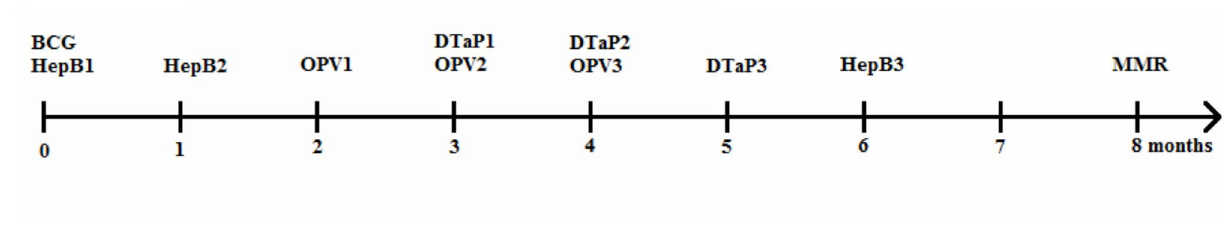
Figure 1. The National Immunization Program schedule for children in China. BCG: bacillus Calmette–Guérin HepB: hepatitis B vaccine OPV: oral poliomyelitis vaccine. DTaP: diphtheria, tetanus, and pertussis MMR: measles, mumps, and rubella vaccine. doi: